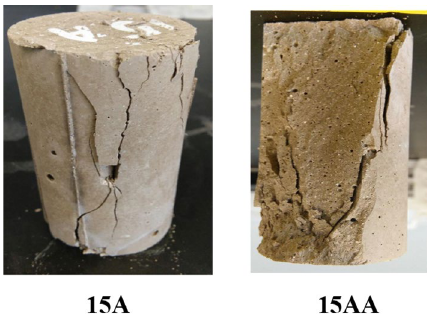
Fig. 3 Cement samples of 15 ppg after a compressive strength test 60 °C and 90 °C